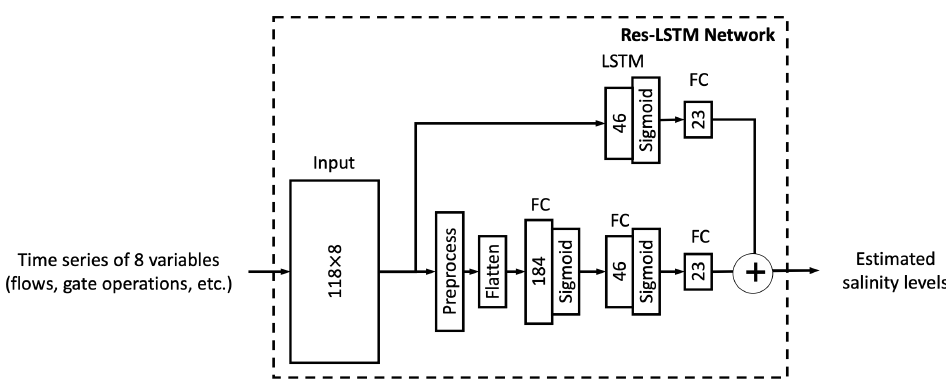
Figure 3. Diagram of the proposed Res-LSTM network. The number in the input layer denotes input shape and those in the subsequent layers represent the numbers of units / neurons of those layers.